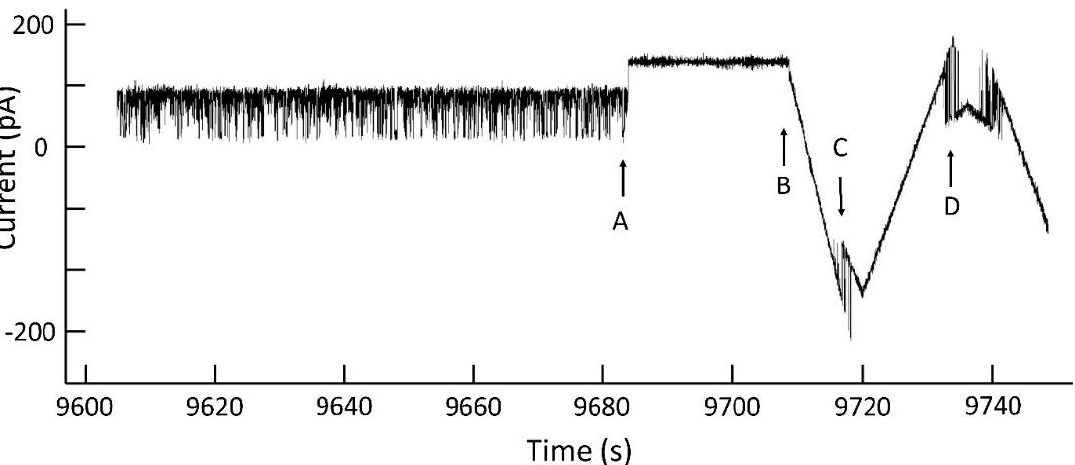
Figure 15. Subunit 3 oscillations between the open and closed states terminate when subunit 2 opens. The left part of the figure shows the oscillations of subunit 3 held at 34 mV. At point (A), subunit 2 opens, thus, locking subunit 3 in its open state. At point (B), a triangular voltage wave was applied. Subunit 2 closure took place in the region labeled (C) and subunit 3 closure in the region labeled